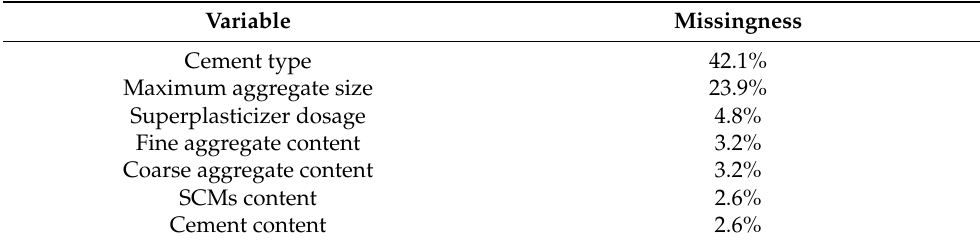
Table 1. Percentage of missing values for selected